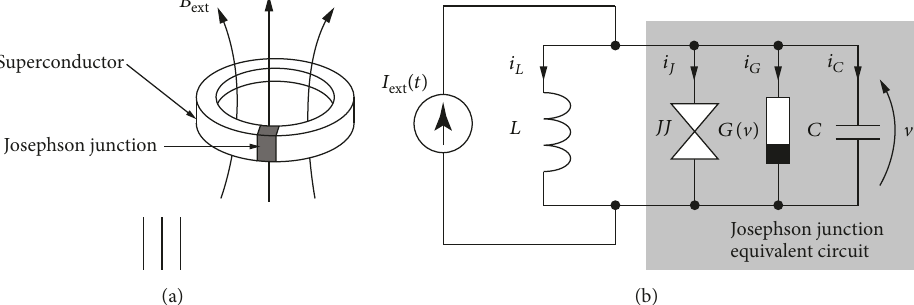
Figure 1: (a) Single-junction superconducting quantum interferometer with external flux 𝐵 ext . (b) An equivalent circuit of